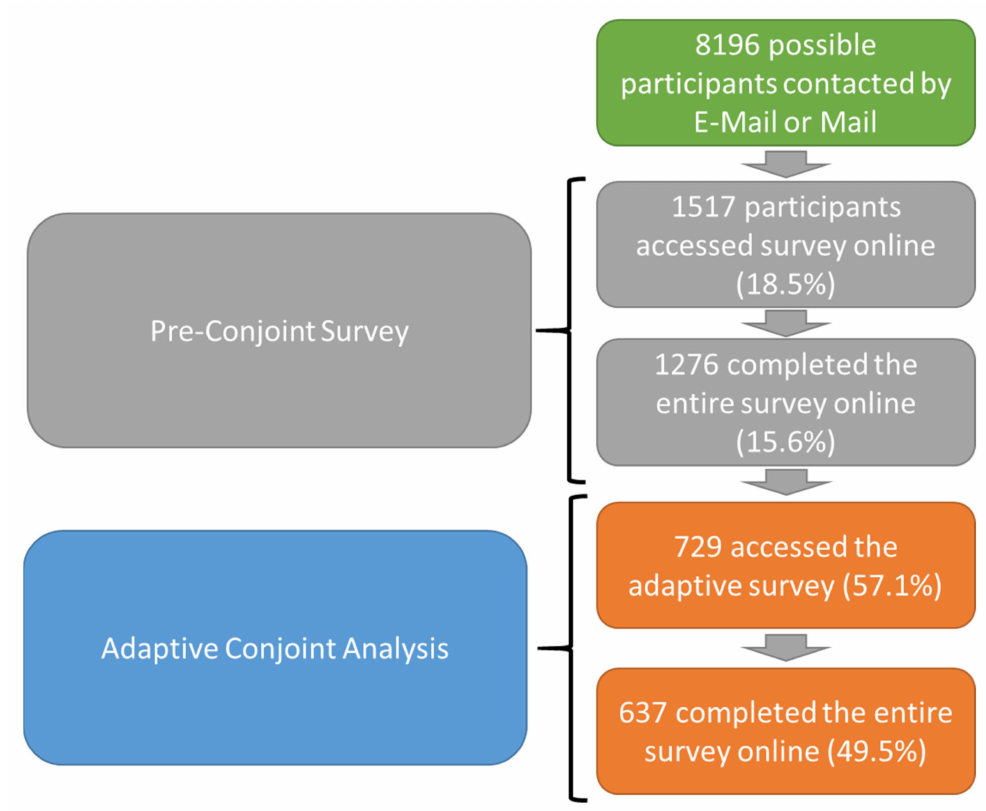
Figure 2. Overview over the study design and the response rates starting from the entire cohort of adult CHD patients with e-mail/mail addresses available to those who participated in the conjoint analysis (see text for